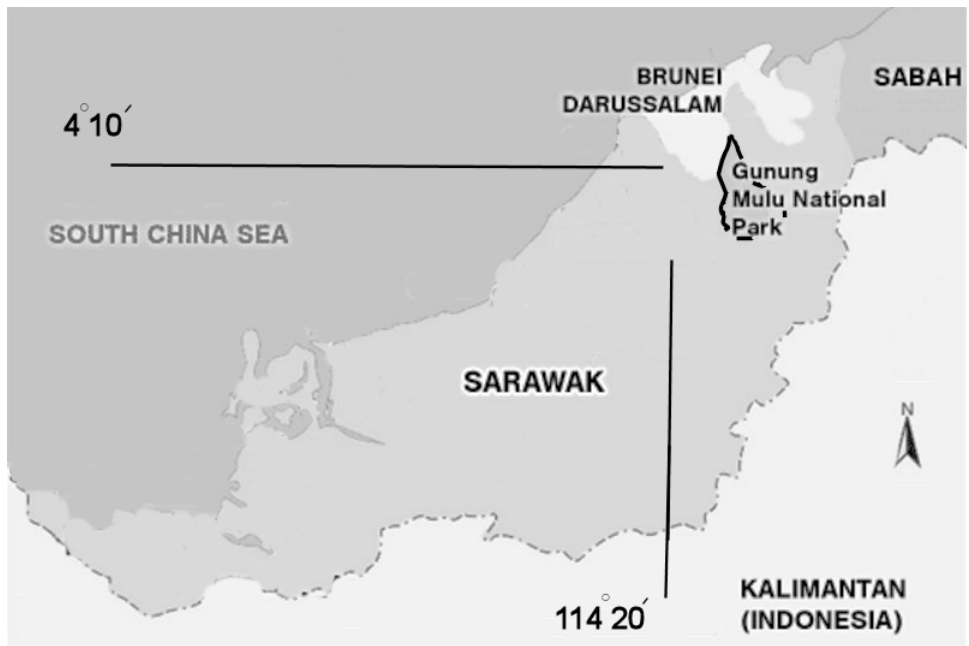
Fig. 1. Map of Sarawak showing location of the Gunung Mulu National Park where the Ptiliidae were